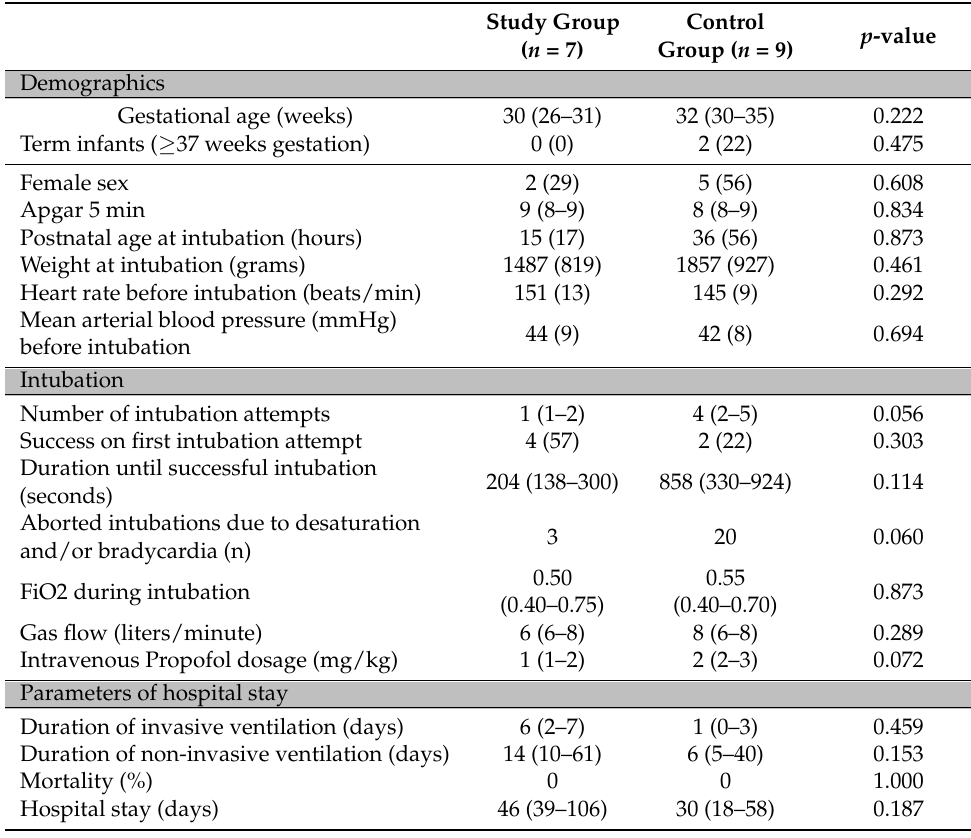
Table 1. Demographics and intubation characteristics. Data are expressed in n (%), median (IQR) or mean (SD) according to normal distribution. FiO 2 = Fraction of inspired oxygen.